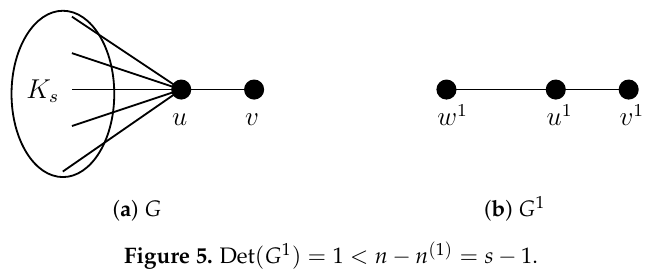
Figure 5. Det ( G 1 ) = 1 < n − n ( 1 ) = s − 1.